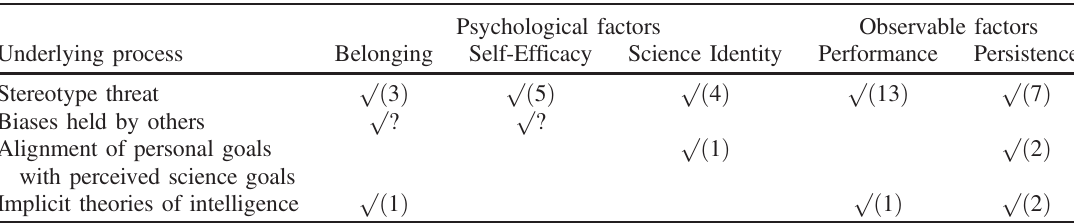
TABLE III. Evidence for the influence of the underlying processes linking sociocultural factors with the p psychological and observable factors for women in STEM. indicates that there is evidence in the literature for a particular process to impact that factor. (the number in parentheses) indicates the number of peer reviewed articles p ? indicates the link has not been explicitly tested but is implied by published studies. supporting this connection. Please refer to text for actual